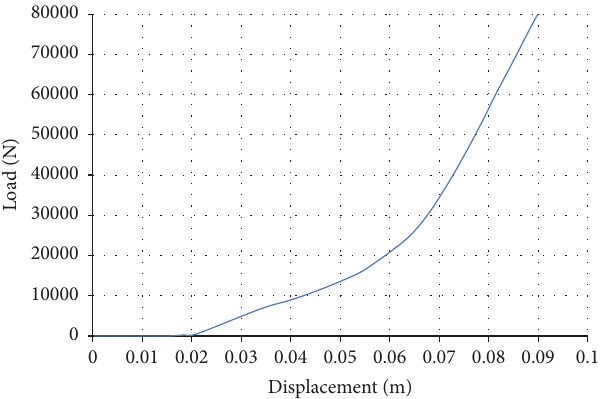
Figure 9: Force-displacement characteristic of the bump stop.